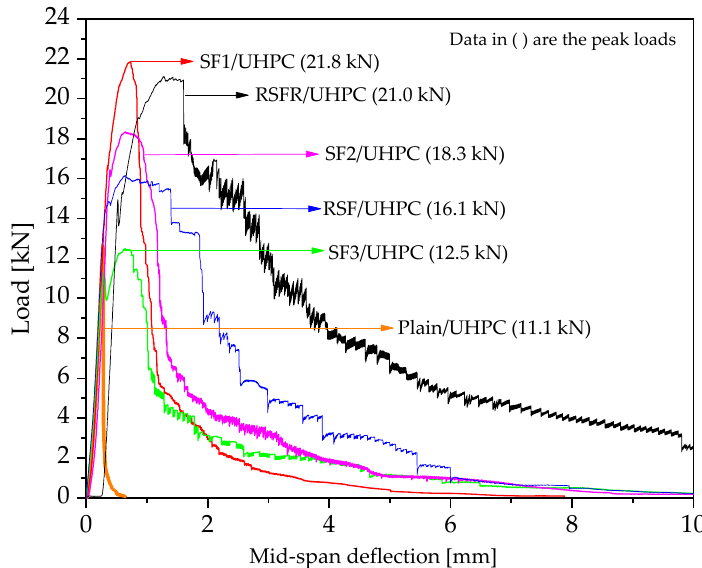
Figure 8. Load–deflection curves of various steel fiber-reinforced UHPC and plain UHPC during fracture energy testing.